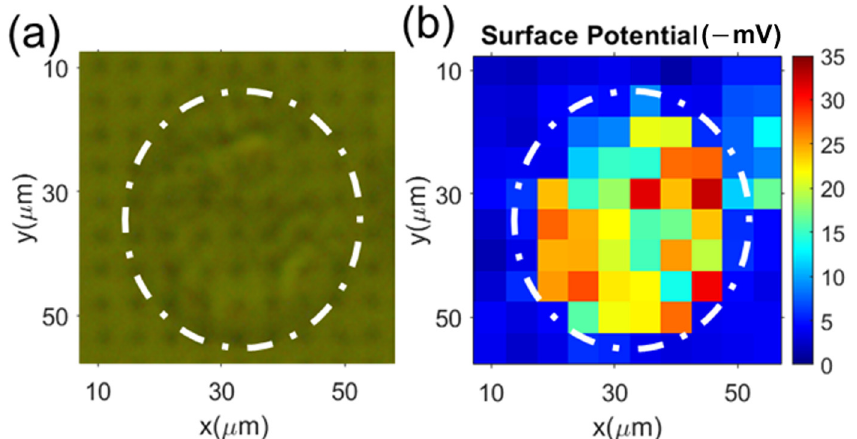
Figure 7. Typical measurement results of the surface charge mapping of hMSC: ( a ) optical images (top illumination) of the cells on the microelectrode array; ( b ) the corresponding surface charge mapping from the reflected images (measured from the back side of the microelectrode chip).